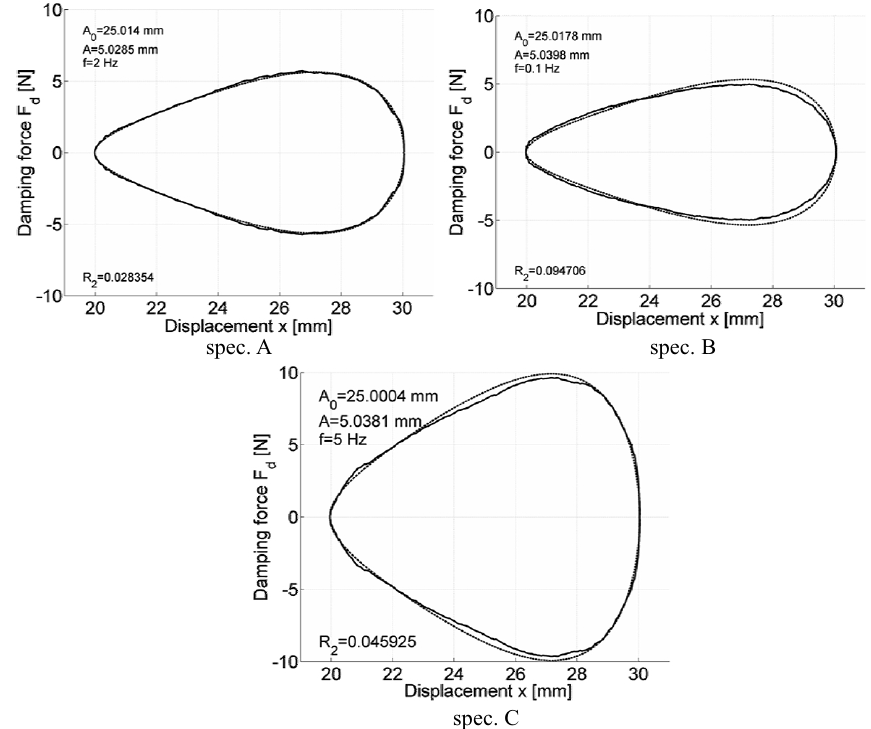
Fig. 6. Results of simulation (Measurement - solid line, Simulation – dotted